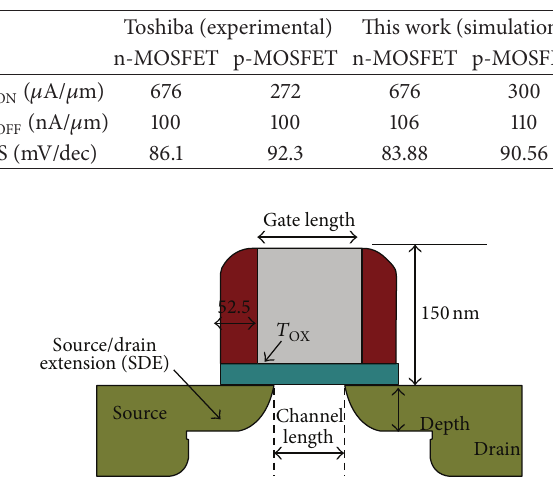
Table 2: Simulation and experimental performance parameters.